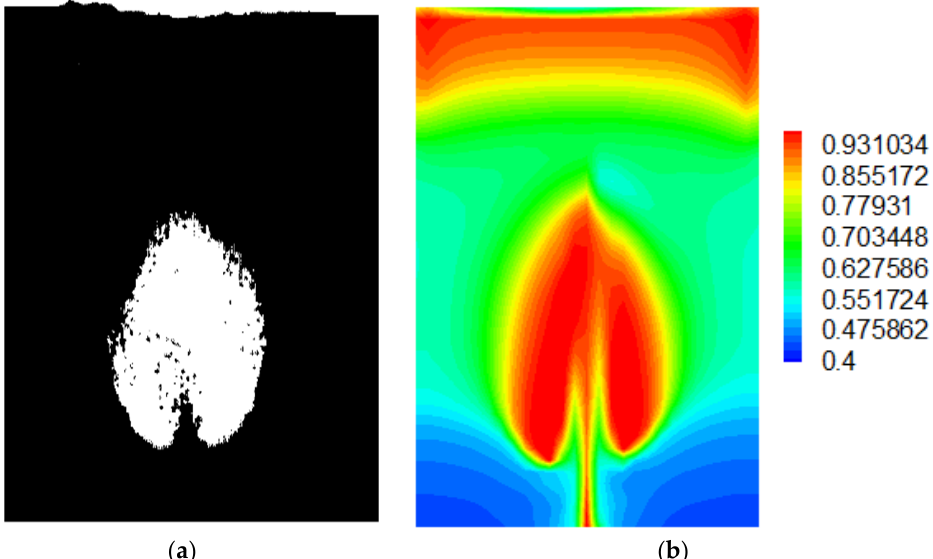
Figure 3. Instantaneous snapshot of particle porosity with Gera’s observation, time = 0.40 s, ρ p = 2700 kg/m 3 . ( a ) Snapshot of Gera’s observation; ( b ) simulation.